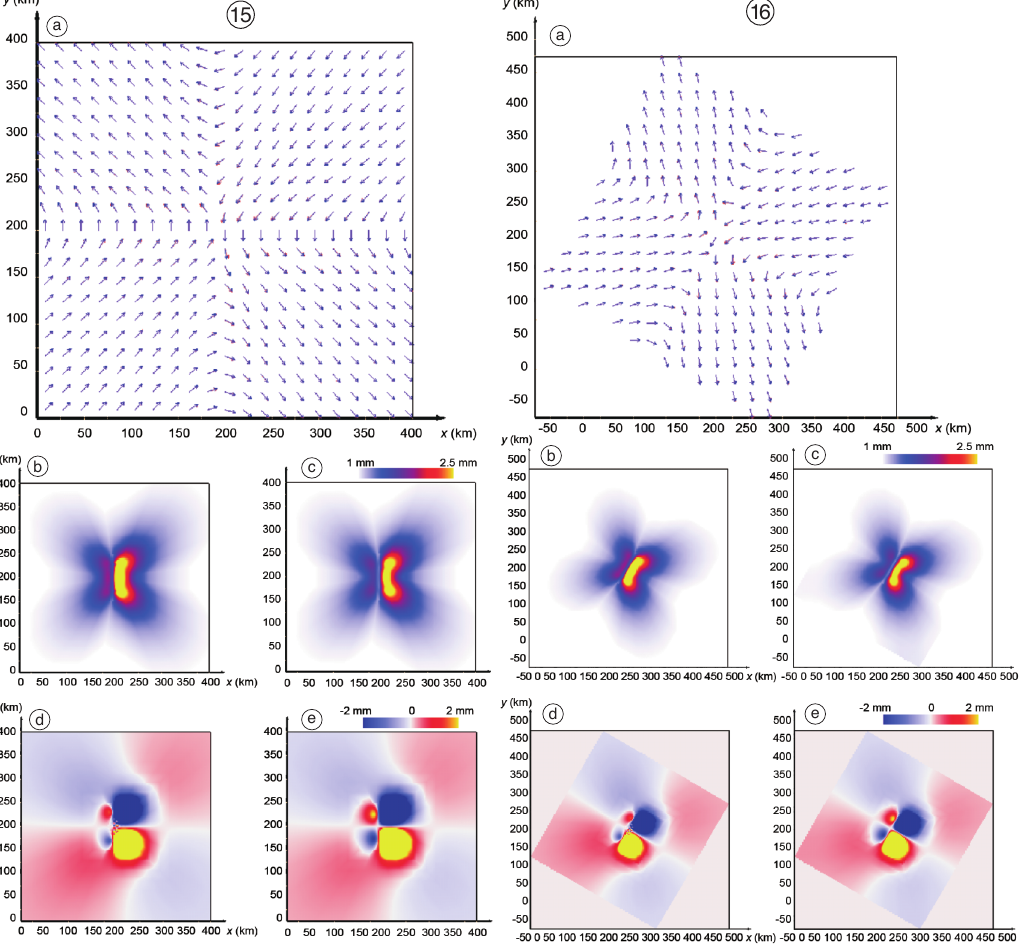
Fig. 15a-e. Same as fig. 11a-e but for a right-lateral strike slip with δ = 60° and φ = 0°.